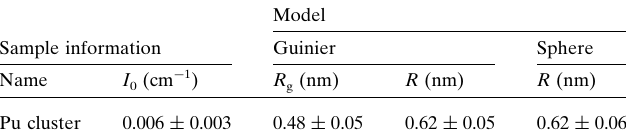
Table 1 X-ray scattering length density ( (cid:2) c ) and electron contrast ( (cid:2) (cid:2) 2 ) used for SAXS diagram simulation calculations.